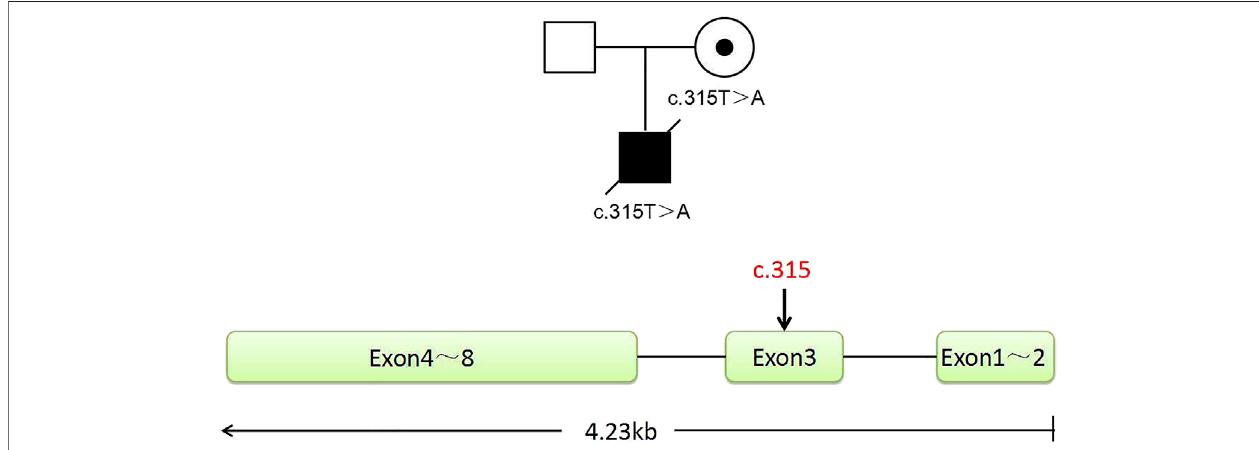
FIGURE 1 | Pedigree of the family. The proband is a deceased hemizygous patient, and the woman is a disease-causing gene carrier, and the man is normal. The IL2RG gene with eight exons is located in the X chromosome Xq13.1. The graph shows the position of the mutant sites of c.315, located in exon 3.